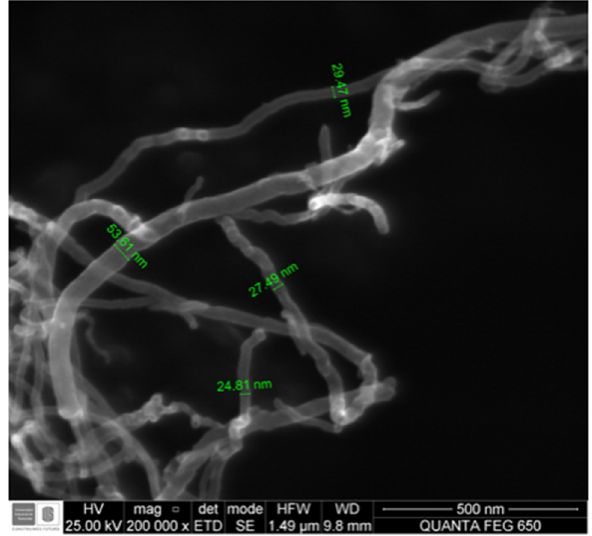
Figure 2. The structure of CNPLUS.